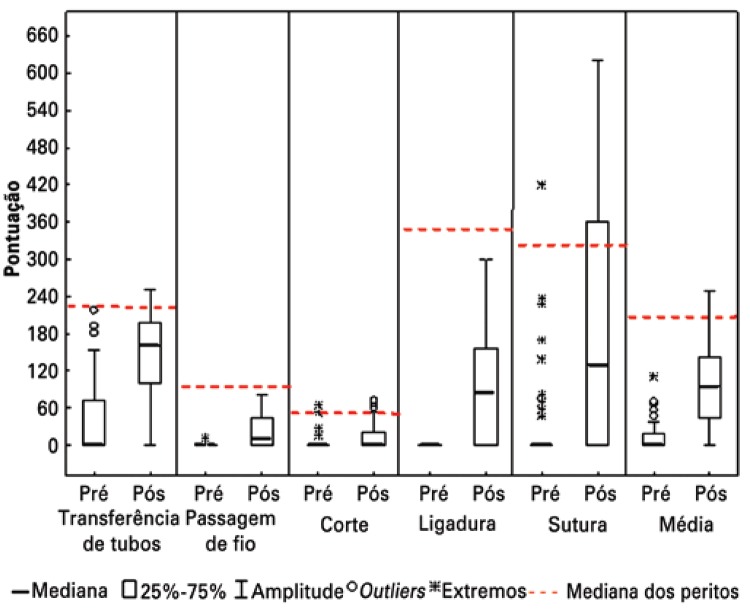
Comparação de pontuação de estudantes de Medicina e peritos para diferentes exercícios laparoscópicos em simuladores